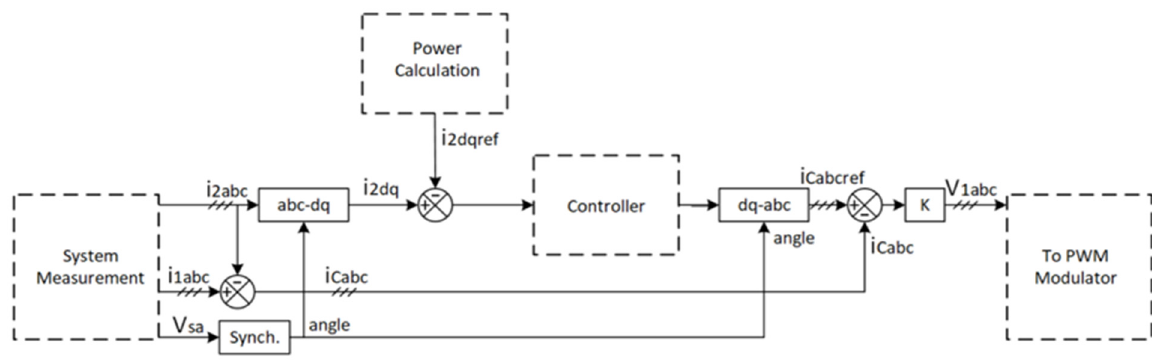
Figure 3. Controller configuration.